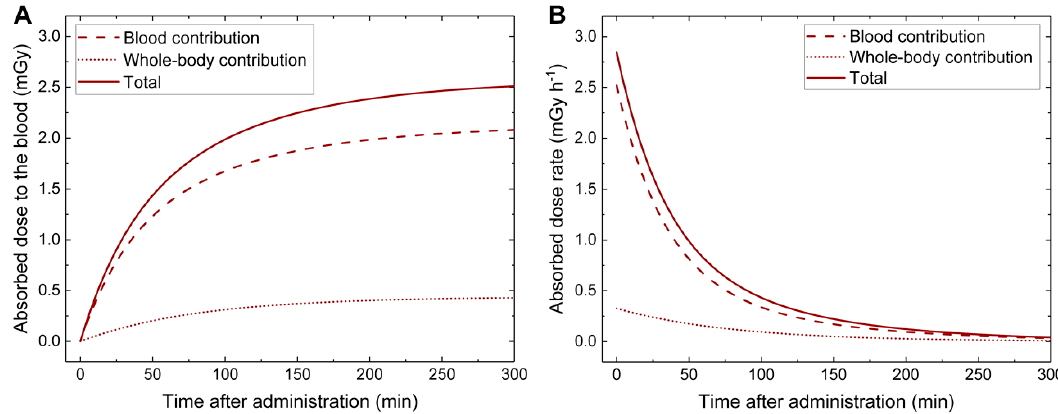
Figure 1. In vivo study—time-dependency of the absorbed dose to the blood and the absorbed dose rate. ( A ) Absorbed dose to the blood as a function of time for a selected patient (P14) with average fit parameters. For this graph, only the absorbed dose to the blood due to 68 Ga administration is considered and the contribution of the computed tomography (CT) has not been taken into account. The contribution of the blood is shown as a dashed line whereas the whole-body contribution is shown as a dotted line. The solid line depicts the total absorbed dose to the blood that is the sum of both contributions. ( B ) The corresponding absorbed dose rates as function of time for the same patient.